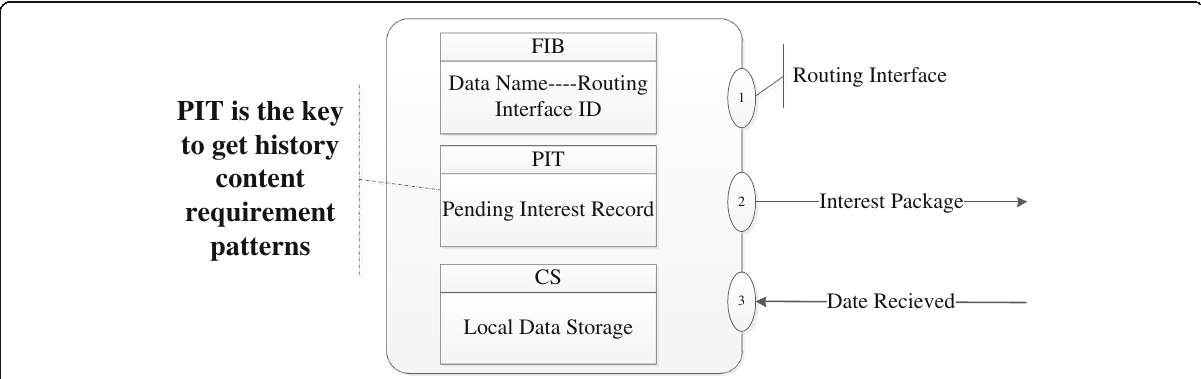
Fig. 4 The importance of pending interest table. When a data requirement is met in a node, the corresponding entry in pending interest table (PIT) is deleted. Nevertheless, it can be argued that PIT is actually a very important foundation to obtain user requirement and interest patterns. Therefore, the past PIT entries should be saved instead of being